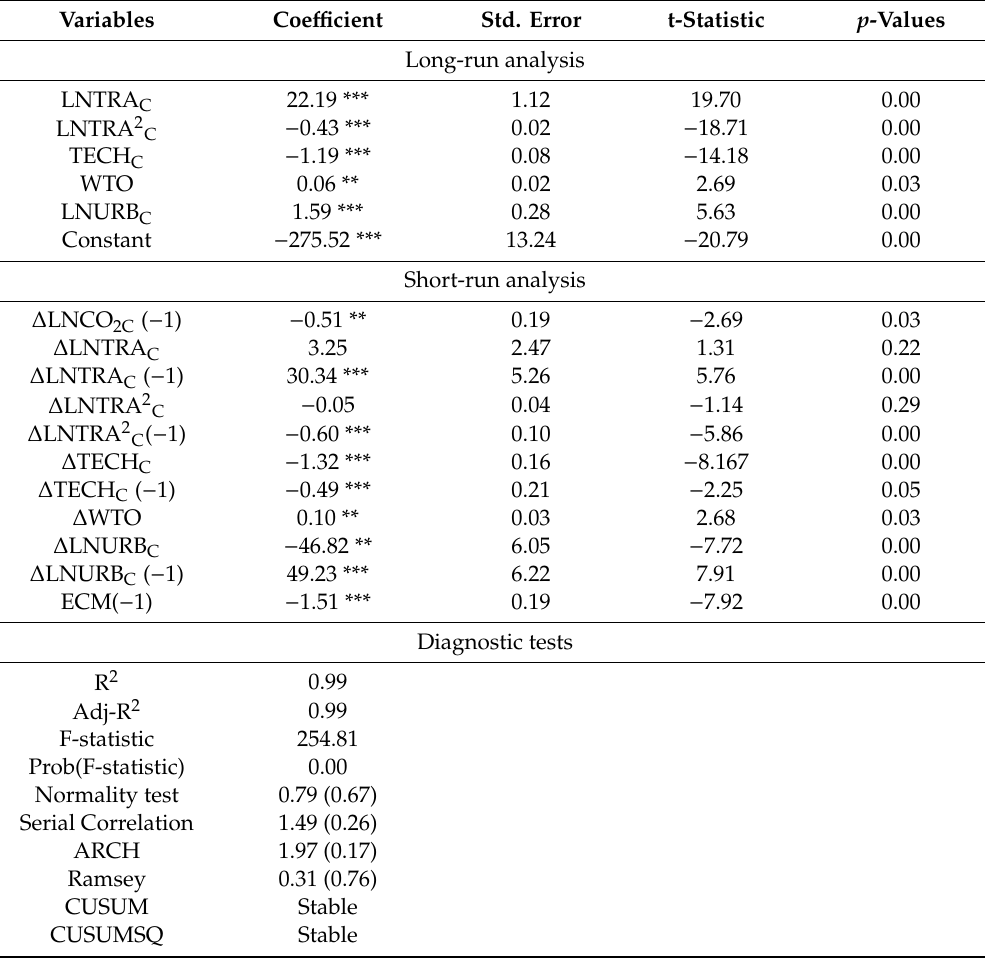
Table 10. Long-run and short-run results of the ARDL method for Model 1. Variables Coe ffi cient Std. Error t-Statistic p -Values Long-run